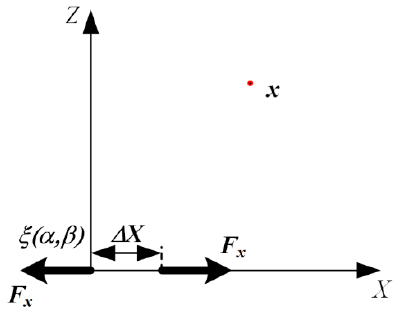
Figure 2. M11 dipole moment excitation.